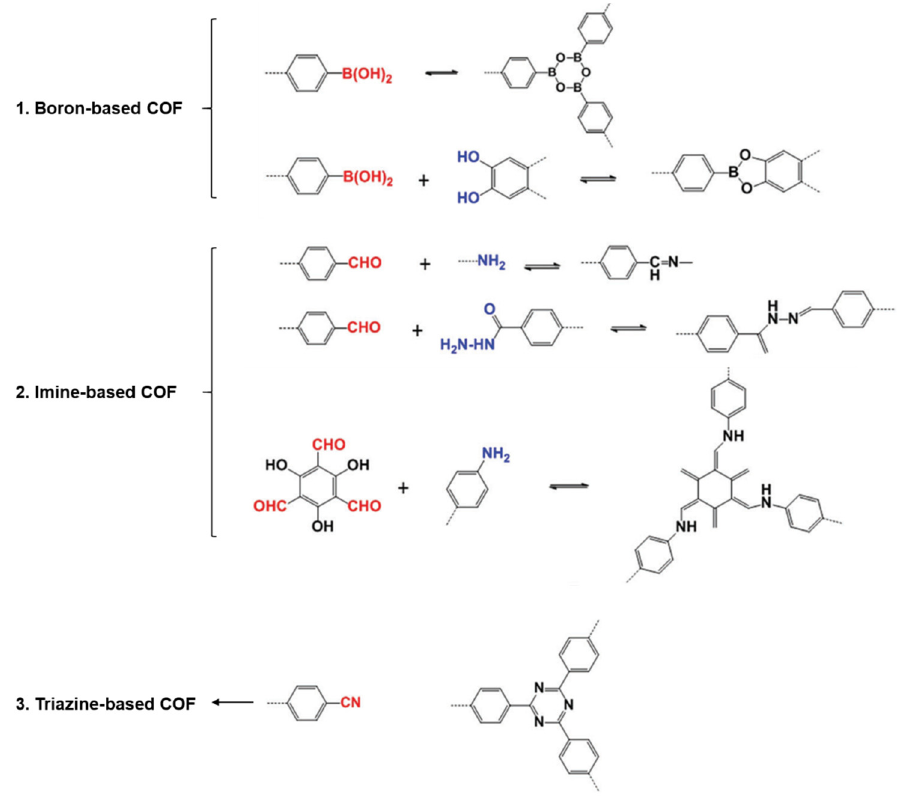
Figure 6. Chemical structures of diverse types of covalent organic frameworks (COFs).